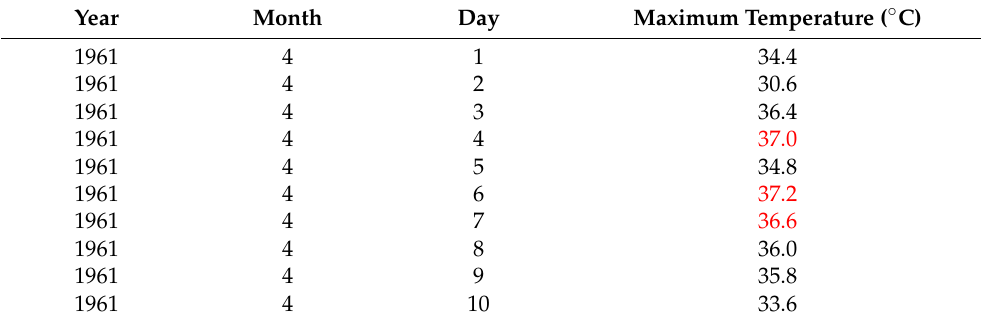
Table 3. An excerpt of the time series of maximum temperature (in degrees Celsius), corresponding to the first 10 days of April 1961, with the doubtful values found by the QCS through the variable limits test highlighted in red. For April, the values of the 1% and 99% percentiles are, respectively, 26.6 ◦ C and 36.4 ◦